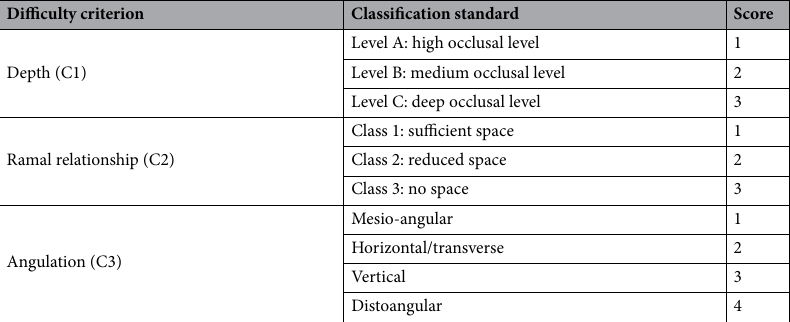
Table 2. Pederson scale used in this study for an evaluation of the difficulty of extraction. Level A: the occlusal surface of the mandibular third molar is at the same level as that of the occlusal surface of mandibular second molar. Level B: the occlusal surface of the mandibular third molar is between the occlusal surface and the cemento-enamel junction of the mandibular second molar. Level C: the occlusal surface of the mandibular third molar is below the cement-enamel junction of the mandibular second molar. Class 1: there is sufficient space between the mandibular ramus and mandibular second molar for the crown part of the mandibular third molar. Class 2: space between the mandibular ramus and mandibular second molar is insufficient for the crown part of the mandibular third molar. Class 3: almost the entire crown of the mandibular third molar is impacted in the